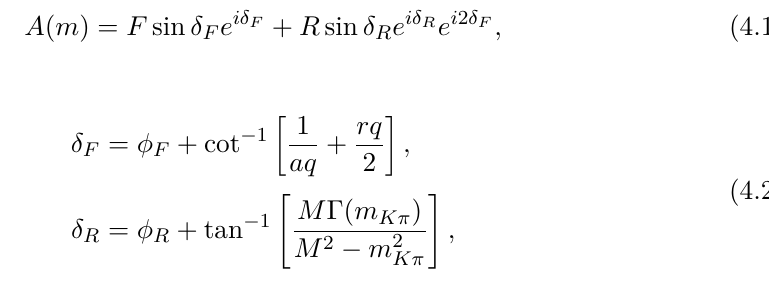
where g α denotes the real coupling constant of the pole m u